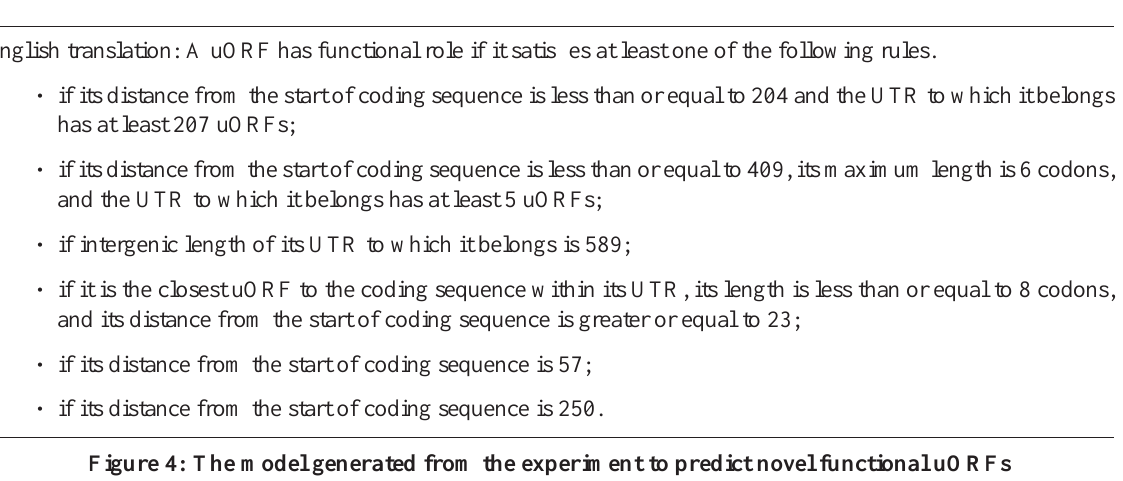
Figure 4: The model generated from the experiment to predict novel functional